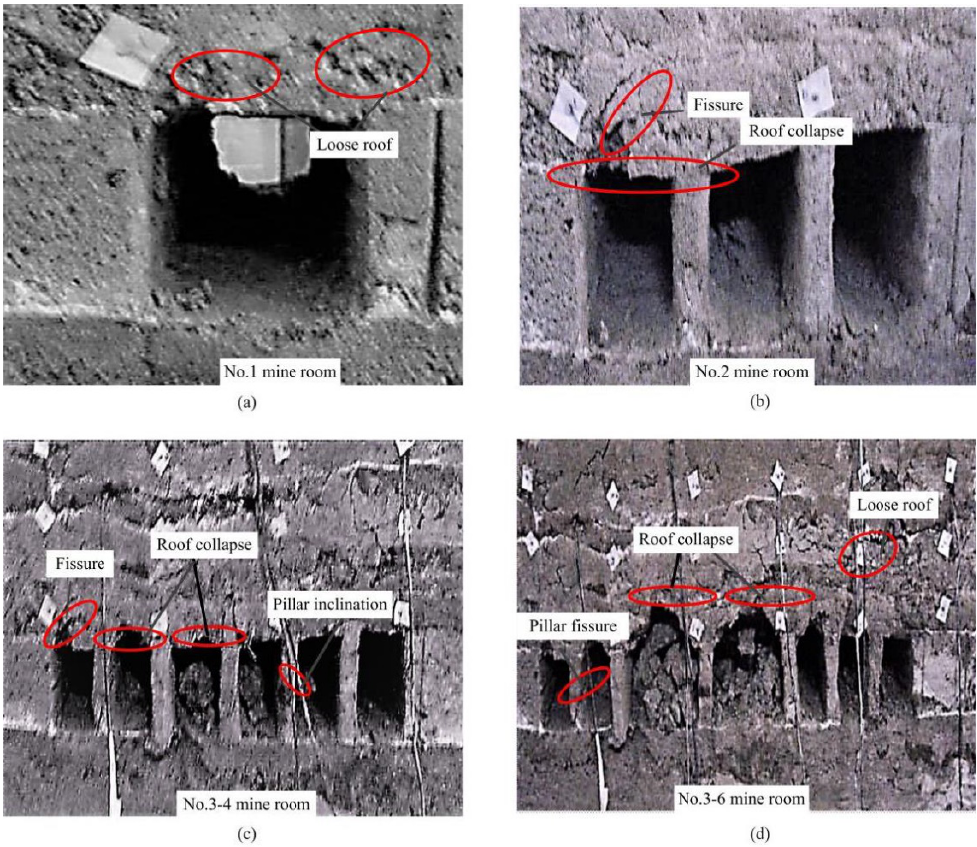
Fig. 5 Deformation and Failure Characteristics of the Roof for the 3-m Ore